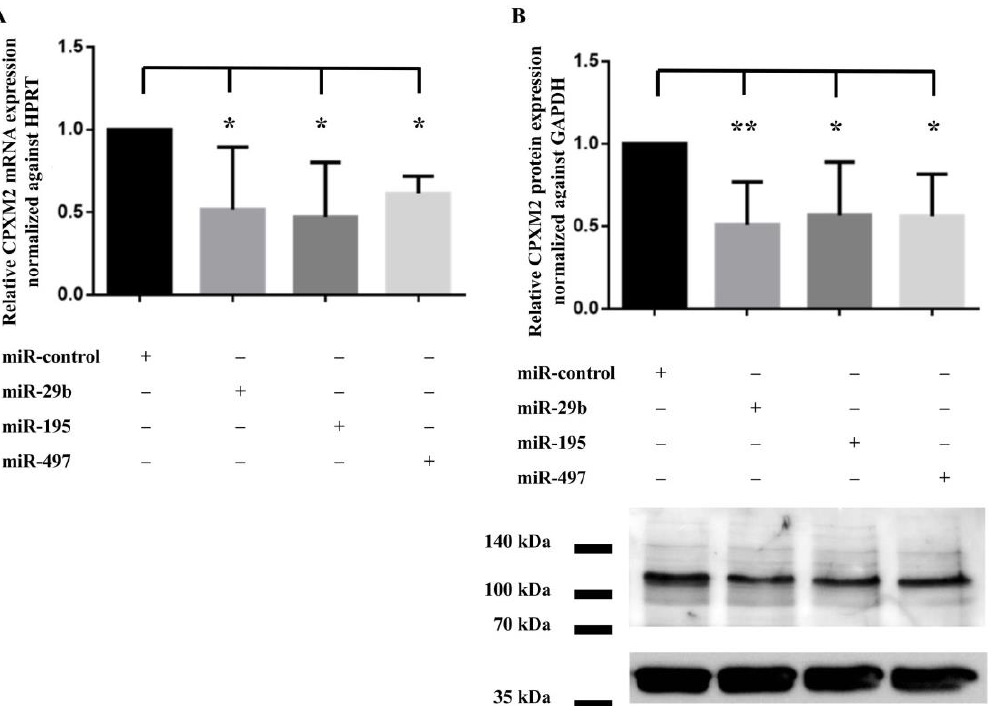
Figure 4. Impact of miR-29b, miR-195, and miR-497 on CPXM2 expression in H9C2 cells. Shown is the relative reduction of CPXM2 ( A ) mRNA and ( B ) protein expression in H9C2 48 h after transfection with miR-29b, miR-195, miR-497, or a negative control miRNA mimics (miR-control), respectively. CPXM2 mRNA expression was normalized against HPRT. CPXM2 protein expression was normalized against GAPDH. Data were presented as relative (x-fold) expression change. (*) p < 0.05; (**) p < 0.01; n ≥ 3.